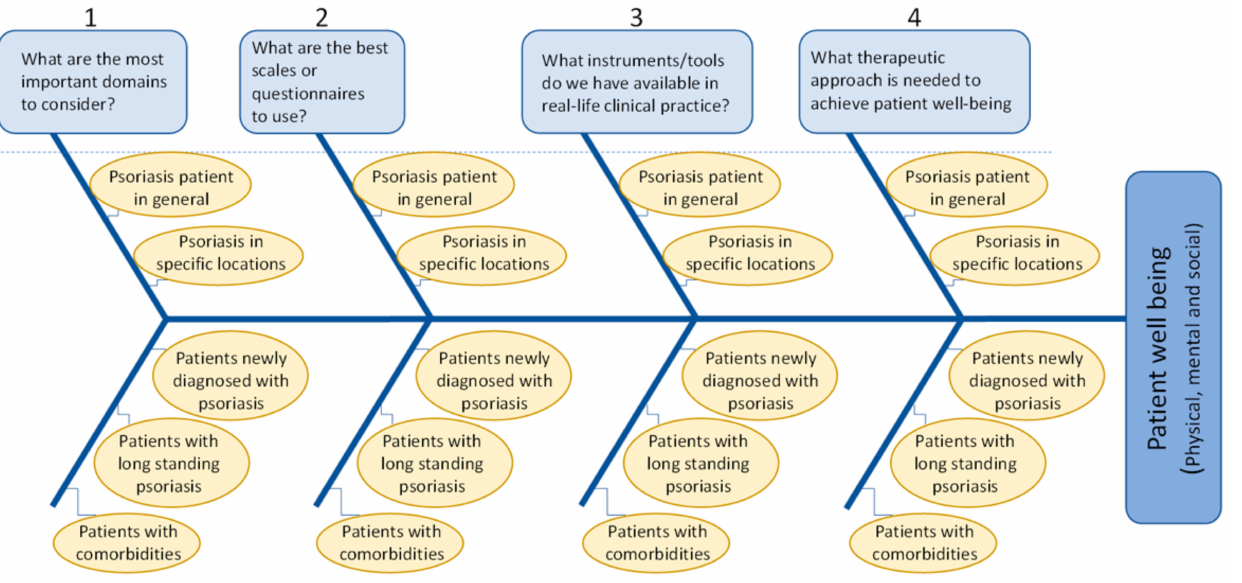
Figure 2. Ishikawa diagram mimics a fish skeleton and summarising the main factors influencing patient wellbeing [26]. The underlying problem (achievement of patient wellbeing) is placed as the fish’s head and the causes/factors extend to the left (numbered 1–4) as the bones of the skeleton; the ribs branch off the back and denote major causes (5 variables for each of the 4 main